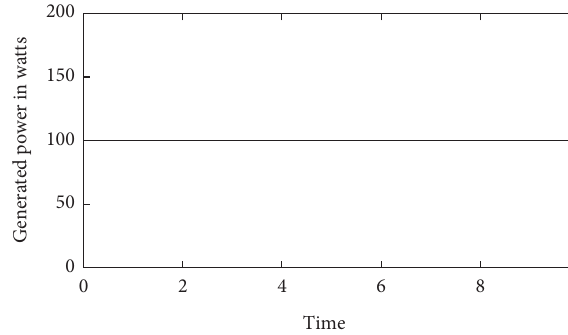
Figure 37: PV voltage across the module.